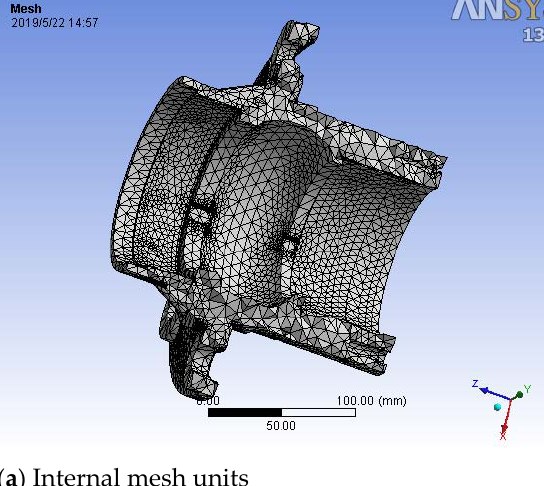
Figure 4. Simplified 3D model of the wheel hub.